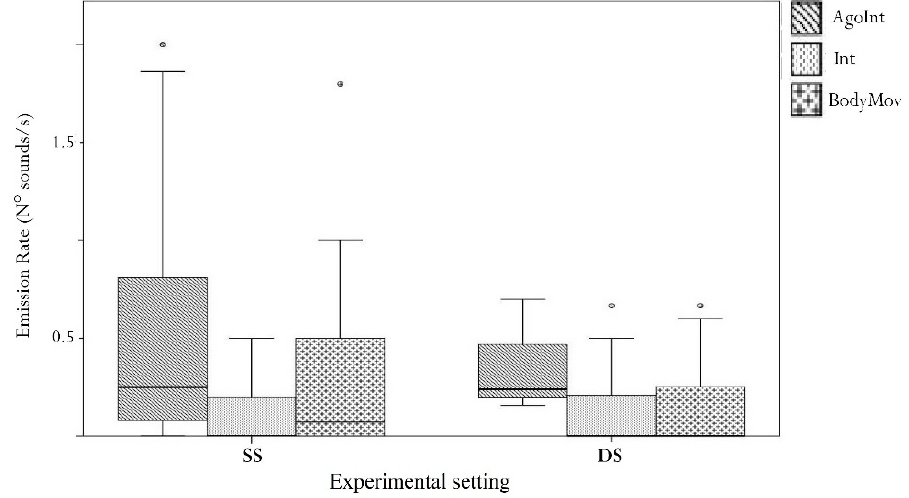
tion (Int), Body Movements (BodyMov), and Agonistic Interaction (AgoInt) behavioural events in-